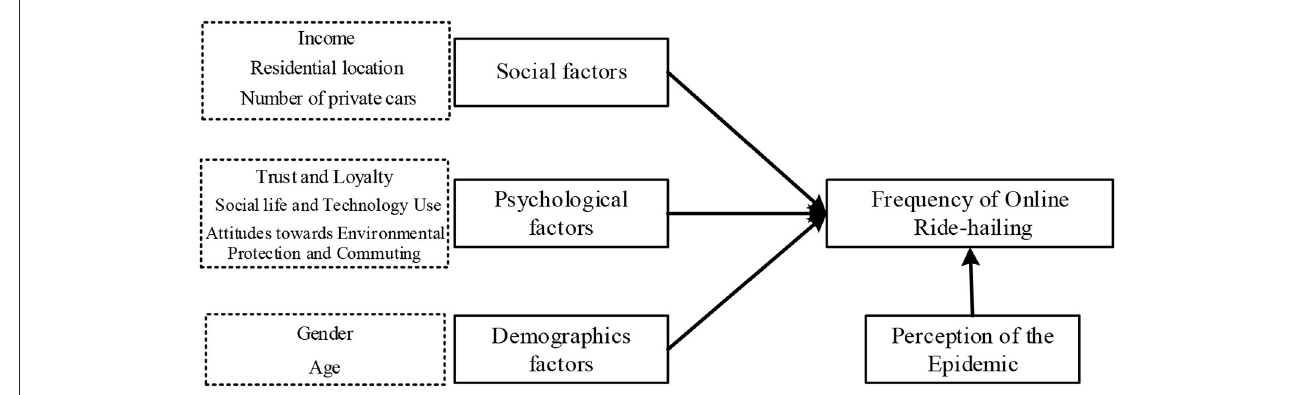
FIGURE1 Typical factors selected in this research.